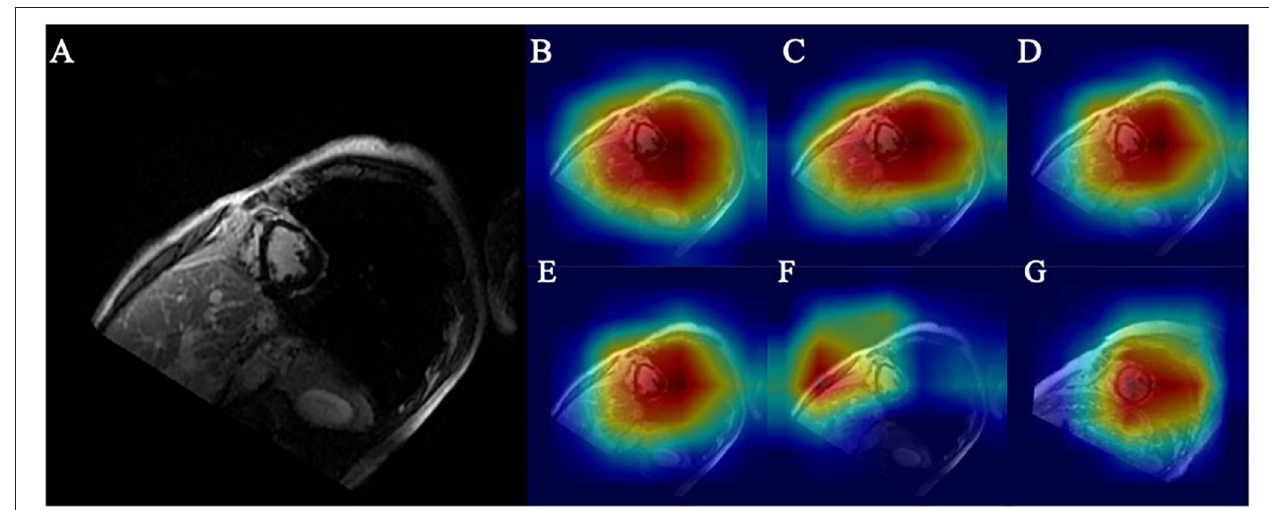
FIGURE 6 | (A) Original ischemic scar image. (B) Heatmap of base model. (C) Heatmap of CA embedded to base model. (D) Heatmap of CA embedded to base model with 4x traditional augmentation. (E) Heatmap of CA embedded to base model with 4x PGGAN augmentation. (F) Heatmap of CA embedded to base model with 4x CycleGAN augmentation. (G) Heatmap of CA embedded to base model with 4x traditional augmentation of image in the control group.